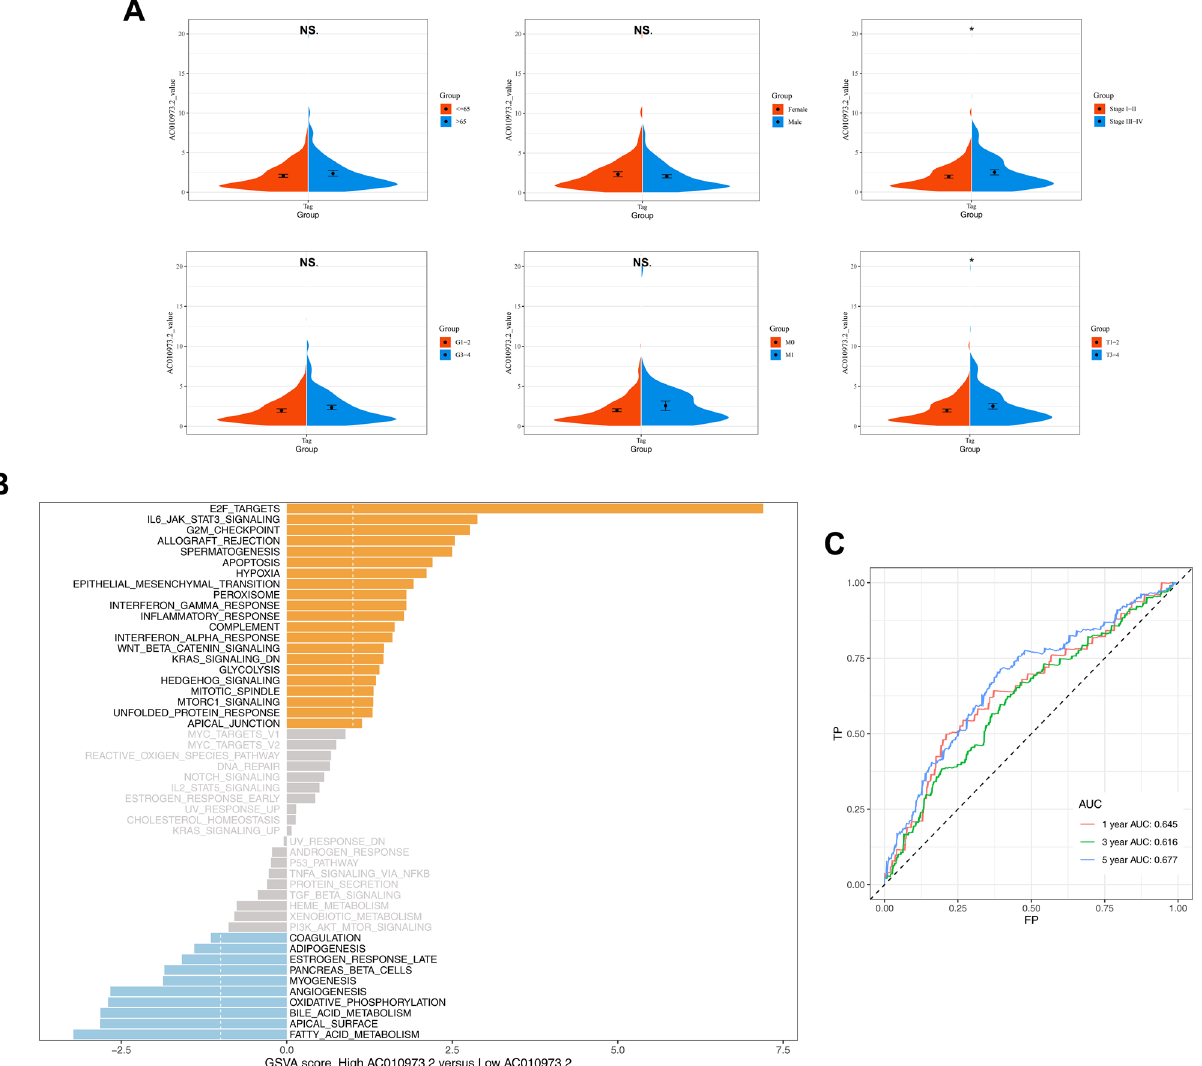
Figure 5. Clinical correlation analysis and GSVA of AC010973.2. Notes: ( A ) Violin plots for distribution of AC010973.2 value in different groups of diverse clinicopathological features in XXX patients from KIRC database. ( B ) Diagram of GSVA on AC010973.2. The collection used was H-hallmark gene sets. Y-axis represented diverse hallmark gene sets. X-axis represented gene sets expression level in high (yellow bars) and low (blue bars) AC010973.2 groups. ( C ) ROC curves for AC010973.2 alone to predict 1-year, 3-year and 5-year OS of ccRCC patients. AUC for them were exhibited in the